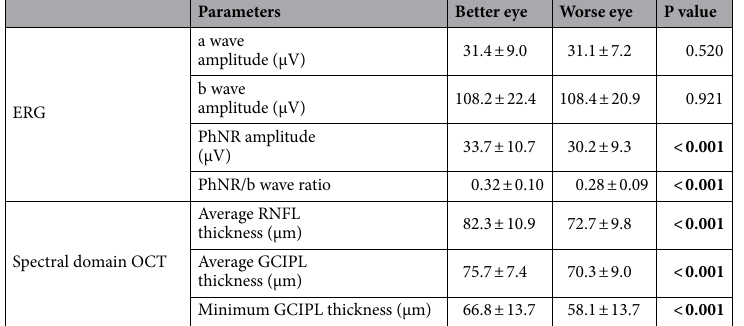
Table 5. Electroretinograms, retinal nerve fiber layer (RNFL) thickness, and ganglion cell-inner plexiform layer (GCIPL) thickness in patients with glaucoma: Intereye comparison. ERG, electroretinogram; GCIPL, Ganglion cell-inner plexiform layer; OCT, optical coherence tomography; PhNR, photopic negative response; RNFL, retinal nerve fiber layer. *Statistically significant differences between two groups ( P < 0.05) by paired t-test are indicated in bold.